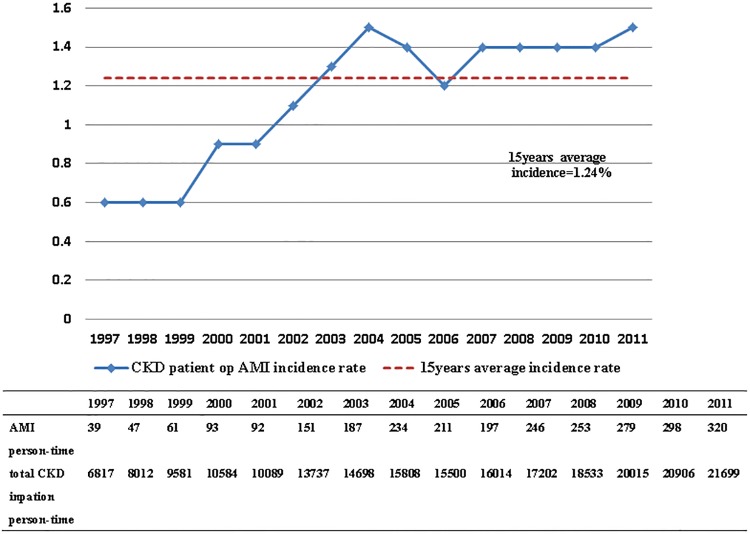
The rate of AMI in all CKD Subjects received surgeries (N = 219195) in 15 years.AMI (Acute myocardial infarction); CKD (chronic kidney disease).